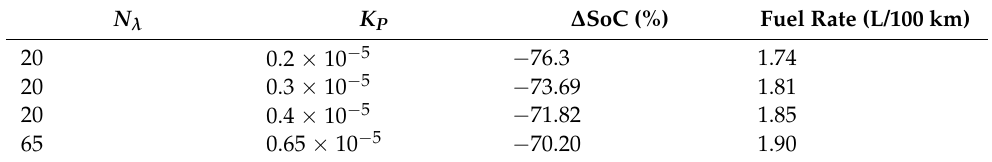
Table 3. Fuel consumption rate and battery balance results during L-Control variation for 10 Nedc cycles. N λ K P ∆ SoC (%) Fuel Rate (L/100 km)